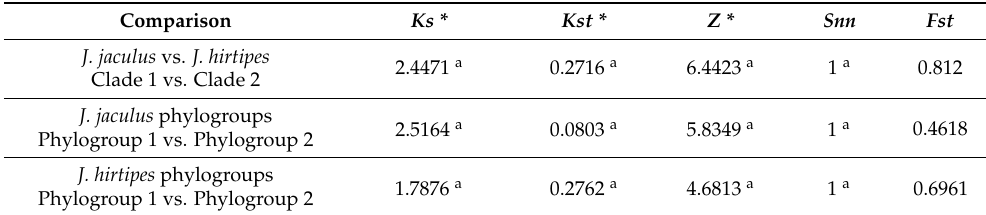
Table 5. Genetic differentiation estimates for Tunisian J. jaculus and J. hirtipes and their phylogroups based on Cytb gene sequences